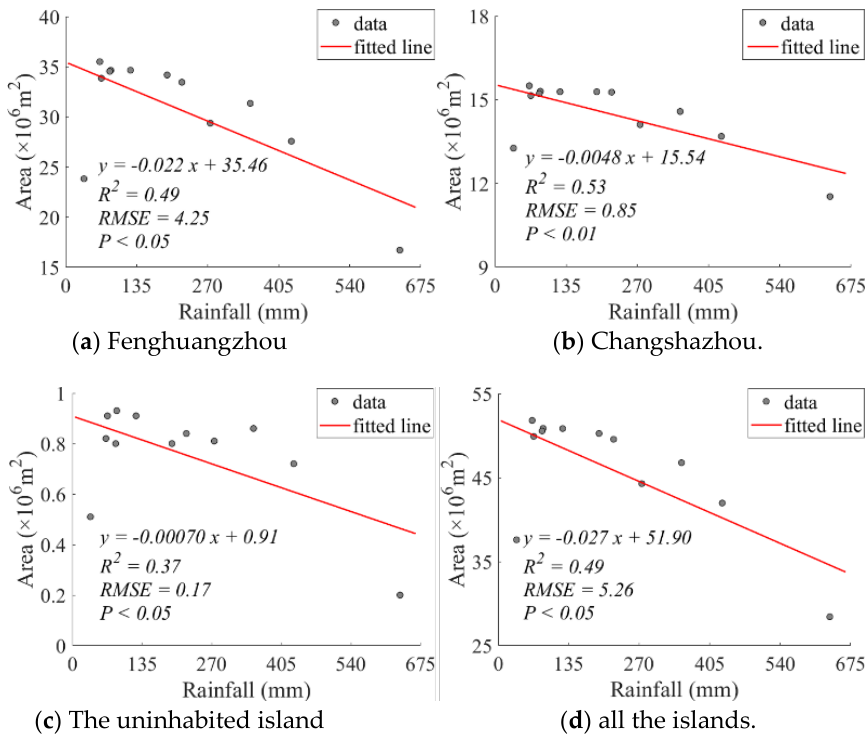
Figure 9. Relationships between monthly area of river islands and the cumulative monthly rainfall of Datong hydrological station.